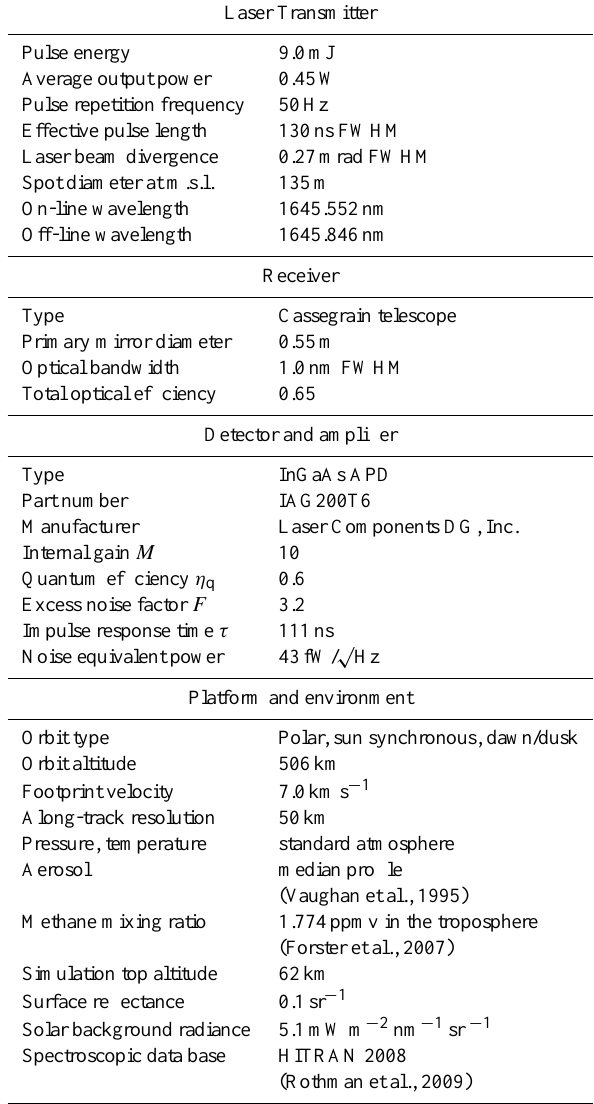
Table 2. Baseline configuration for the main instrument, platform, and geophysical parameters of the space-based methane lidar MER- LIN that provides a methane column measurement precision of